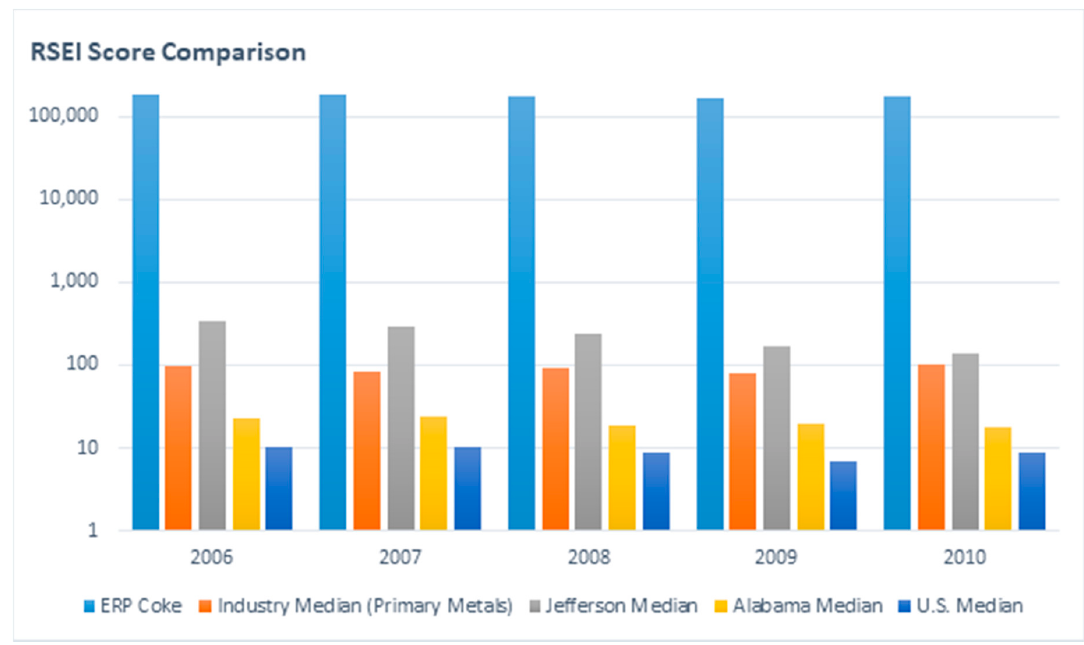
Figure 3. Risk-Screening Environmental Indicators (RSEI) risk scores for ERP Coke and other facilities.